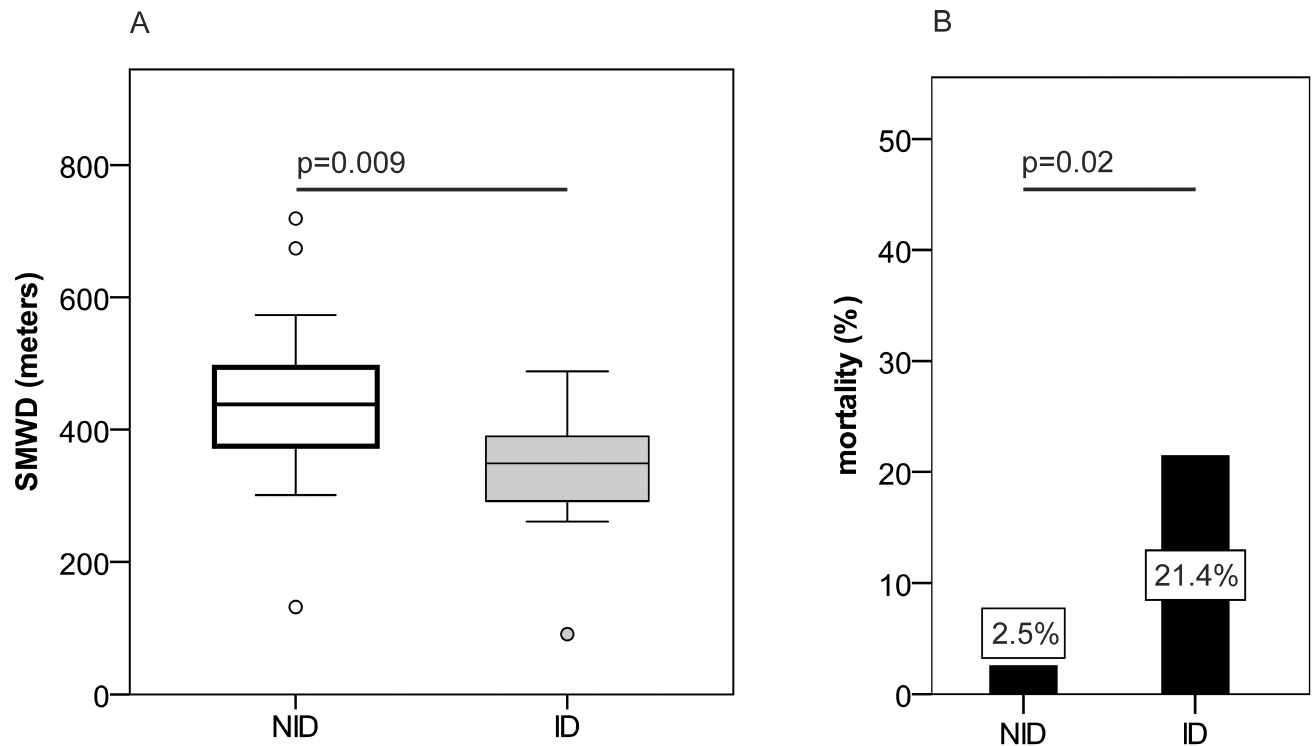
Fig 6. SMWD and mortality of non-anemic precapillary PH patients depending on iron status at follow up in 2015. (A) Six-minute walking distance (SMWD) and (B) observed mortality in non-iron deficient (NID) and iron deficient (ID) patients with precapillary pulmonary hypertension as defined by ID4 at follow up in 2015; N =